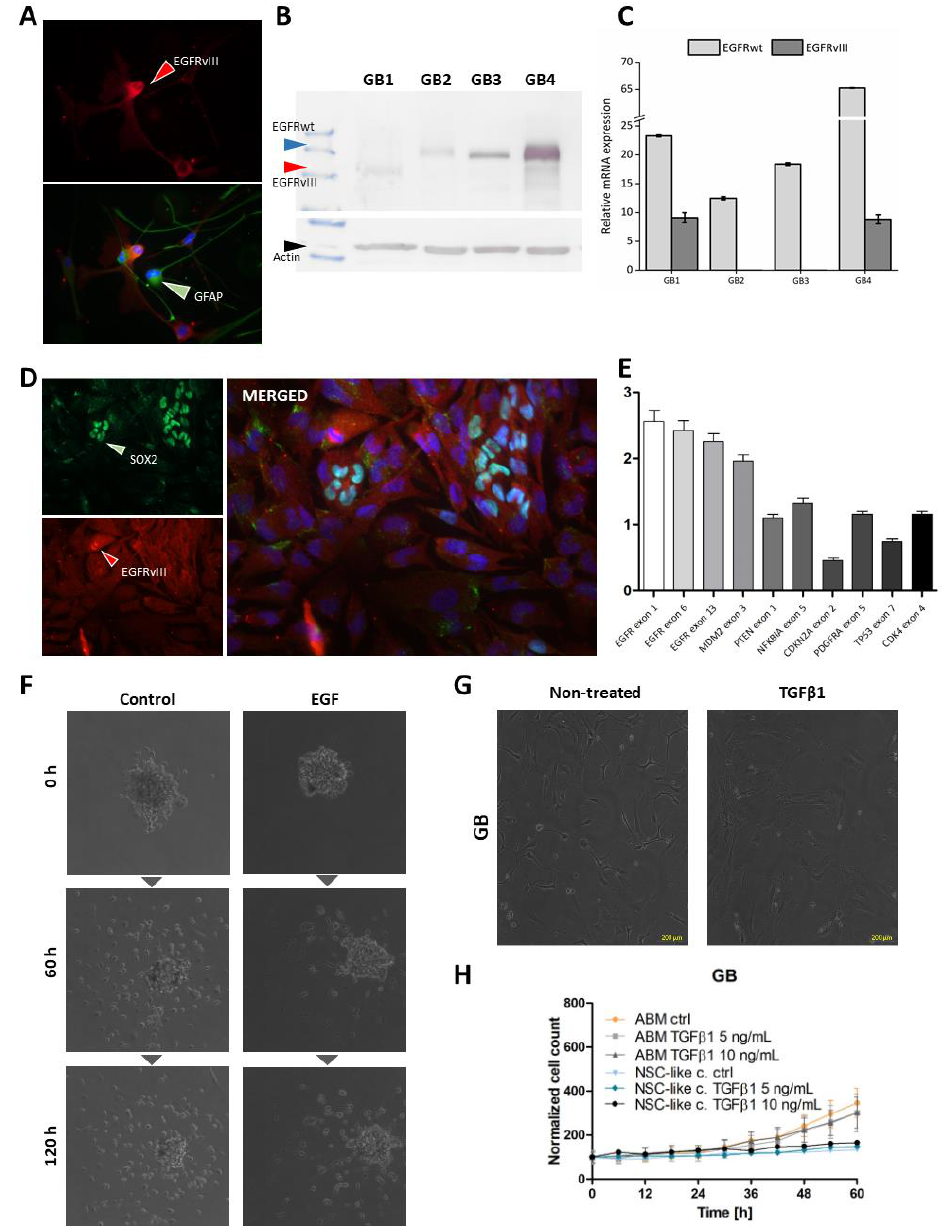
Figure 5. The influence of EGF and TGF β 1 on EGFR vIII -positive primary glioblastoma cell cultures. The characteristics of selected GB primary culture models was confirmed at the protein level by immunocytochemical co-staining of EGFRvIII with GFAP (magnification 400 × ) ( A ) and by Western blotting of EGFRvIII expression, with or without EGFRwt co-expression ( B ), as well as at the mRNA level by real-time qPCR ( C ). Co-staining of EGFRvIII and SOX-2 protein expression revealed both EGFRvIII-positive SOX-2-positive and EGFRvIII-positive SOX-2-negative GB cells in primary cultures; magnification 400 × ( D ). MLPA for EGFRvIII-positive primary GBs (here GB4) was not interpretable due to EGFRwt co-amplification ( E ). Some spheres isolated from the same EGFRvIII-positive primary GB responded to EGF by proliferation while others deteriorated; magnification 100 × ( F ). The influence of TGF β 1 on the primary GB cell line with confirmed EGFRvIII expression was analyzed. GB cell morphology was initially mixed between mesenchymal and epithelial; however, after 48 h of TGF β 1 treatment, this changed to a mesenchymal phenotype’ magnification 100 × ( G ). The GB proliferation ratios in different cell culture conditions (ABM or NSC-like) after treatment with 5–10 ng/mL TGF β demonstrated that the number of normal cells increased with the mesenchymal phenotype ( H